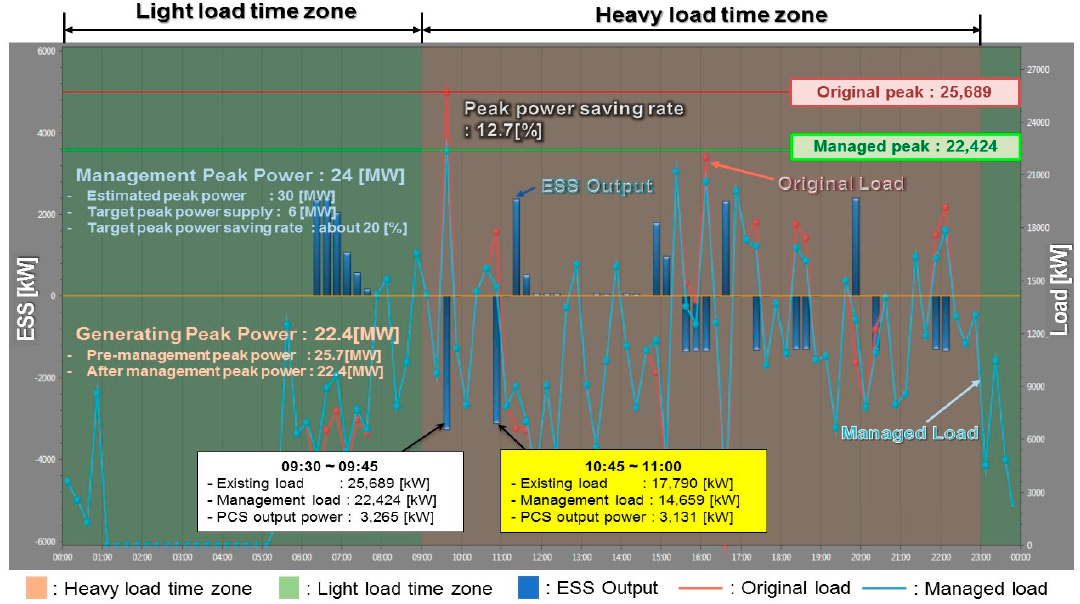
Figure 23. Results of PMS daily operational data analysis (KEPCO I-Smart interlink analysis data).